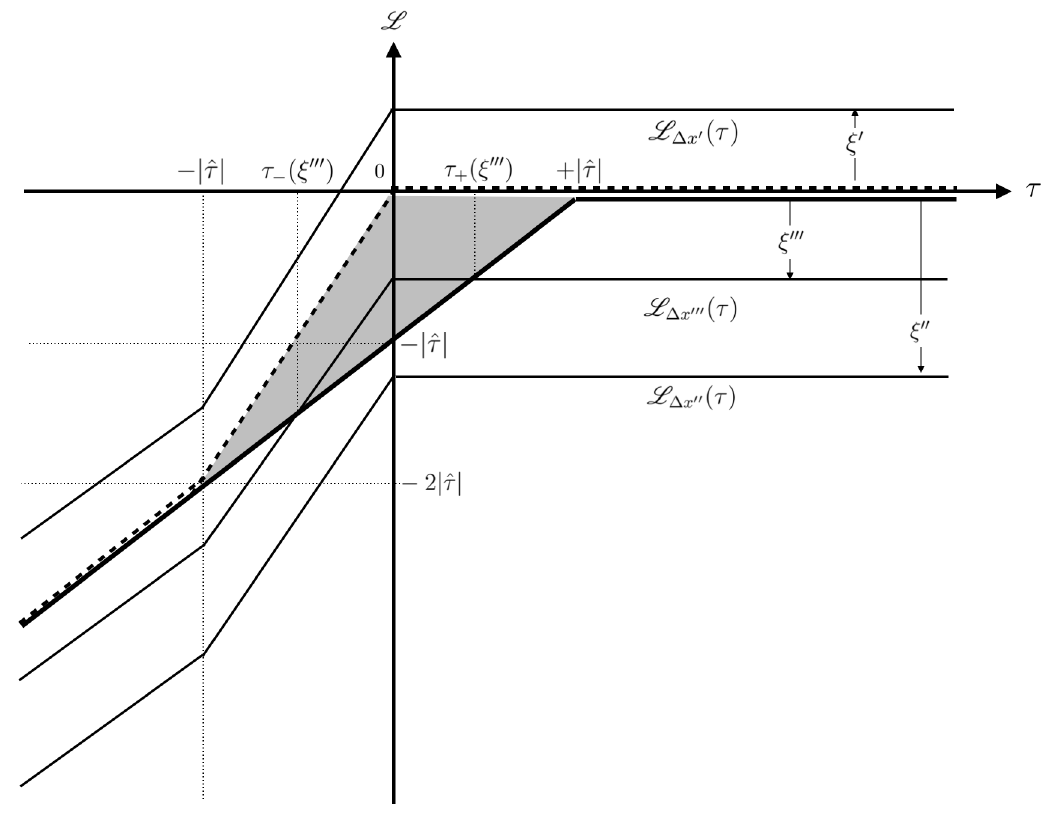
Figure 13. Scale history analogous to figure 12. The proper length scales L ∆ x ( τ ) of various geometric structures are depicted in addition; they evolve parallel to L H ( τ ) , having different offsets ξ though. The structure with comoving size ∆ x 000 is seen to go super-COM between τ − ( ξ 000 ) and τ + ( ξ 000 ) , respectively. It always remains of sub-Hubble size, however. In figure 13, the proper lengths of all such structures pass through the shaded